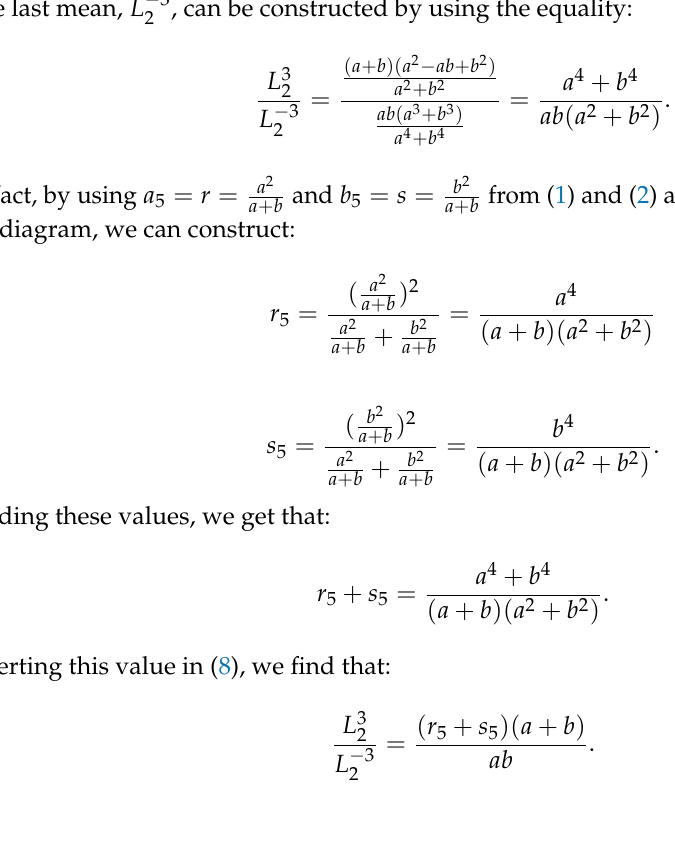
Figure 7. Geometric constructions of r 3 Figure 7: Geometric constructions of r